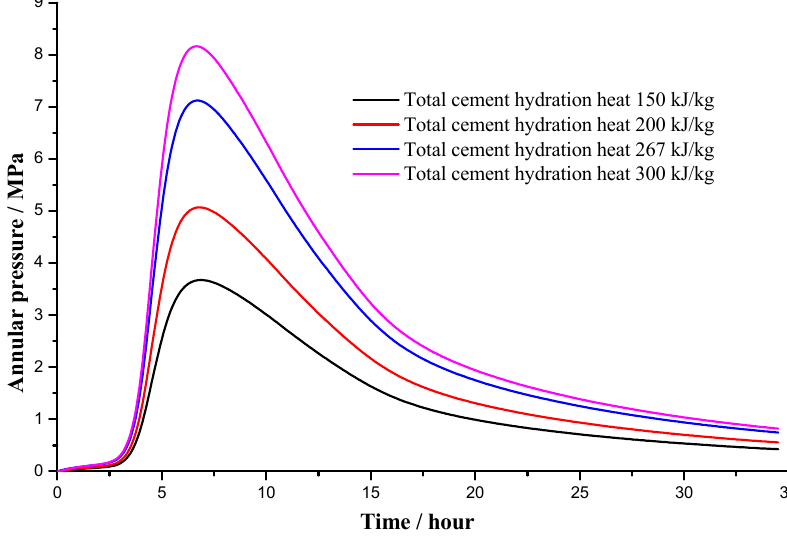
Figure 13. Annular pressure under different cement hydration heats.